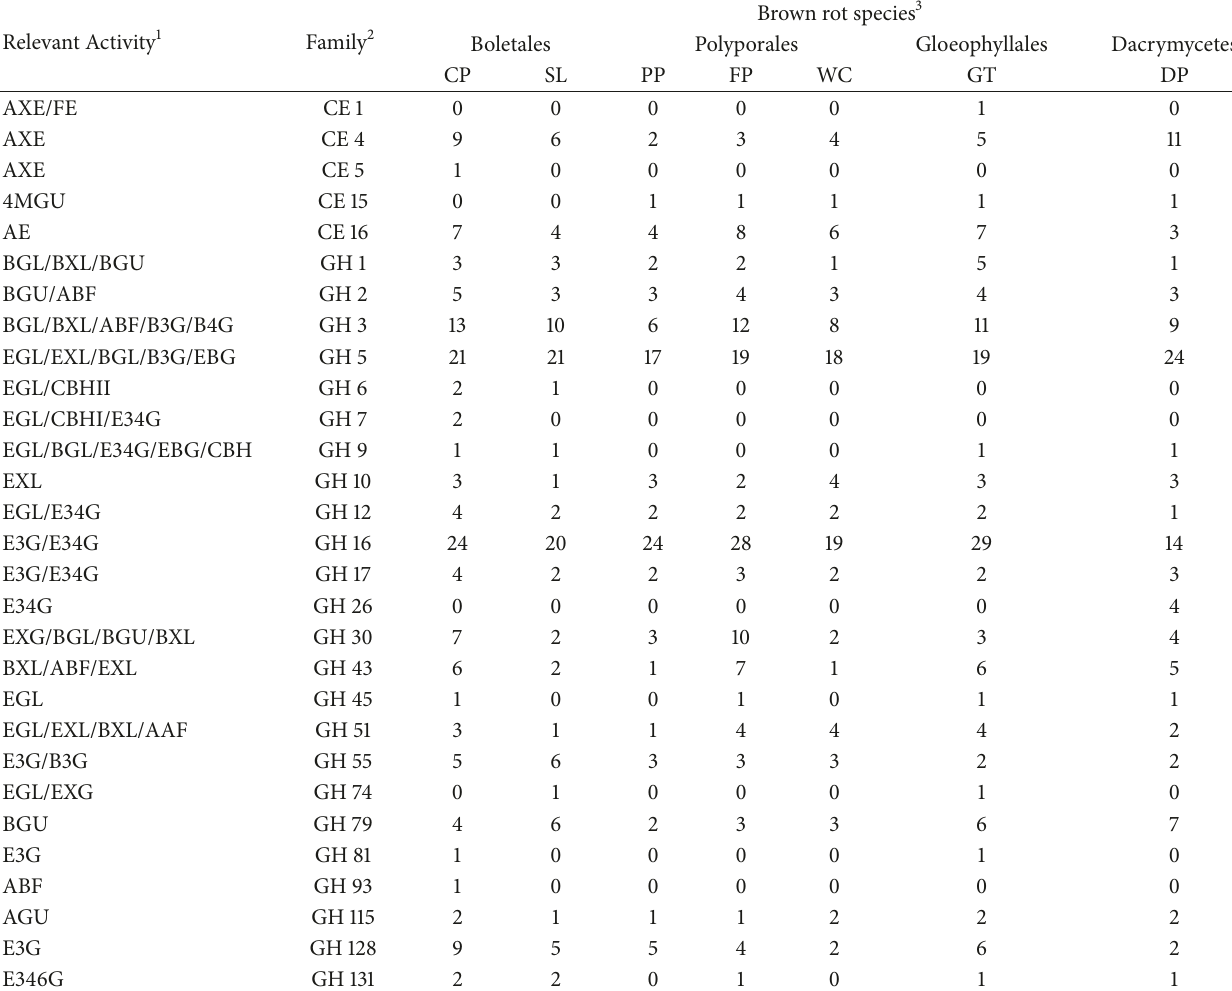
Table 2: Number of copies of gene families with activity on glucuronoarabinoxylan, cellulose, and mixed linkage glucan present in the genomes of seven brown rot fungi. The major taxonomic affiliations are shown, SL, Serpula lacrymans , CP, Coniophora puteana , WC, Wolfiporia cocos , PP, Postia placenta , FP, Fomitopsis pinicola , GT, Gloeophyllum trabeum , DP, Dacryopinax